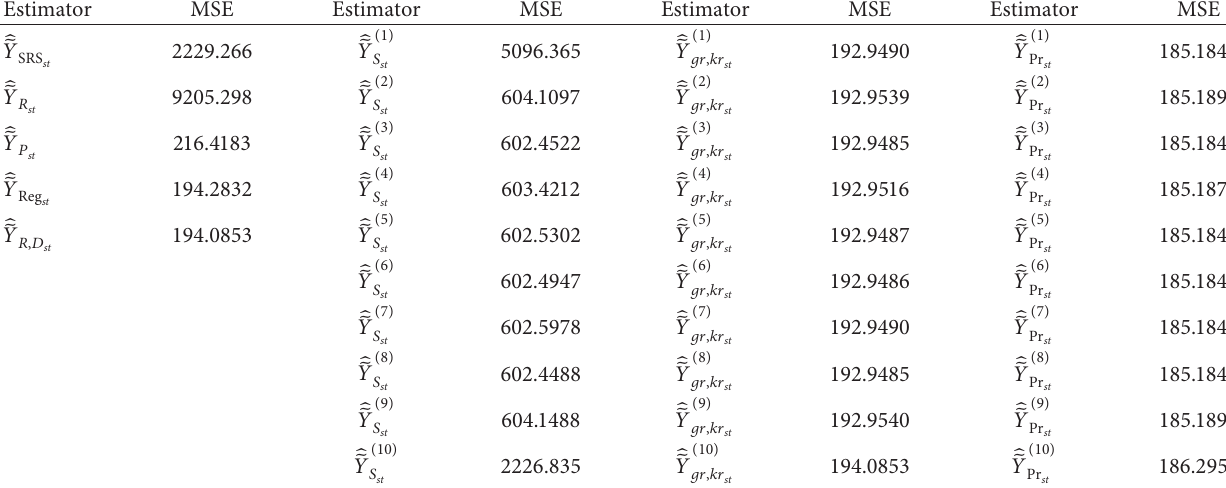
Table 6: MSEs using population 1 (scenario